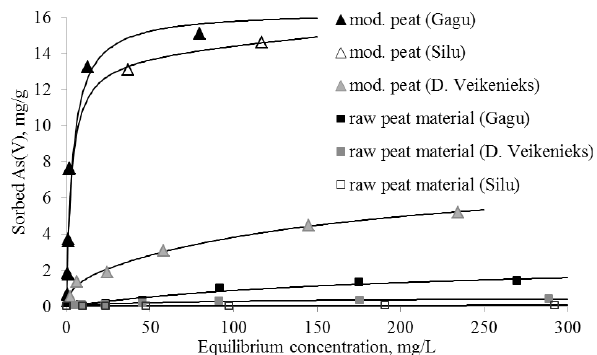
Figure 3: Removal of As(V) using Fe-modified peat and raw peat material, sorption time 24 h at room temperature.